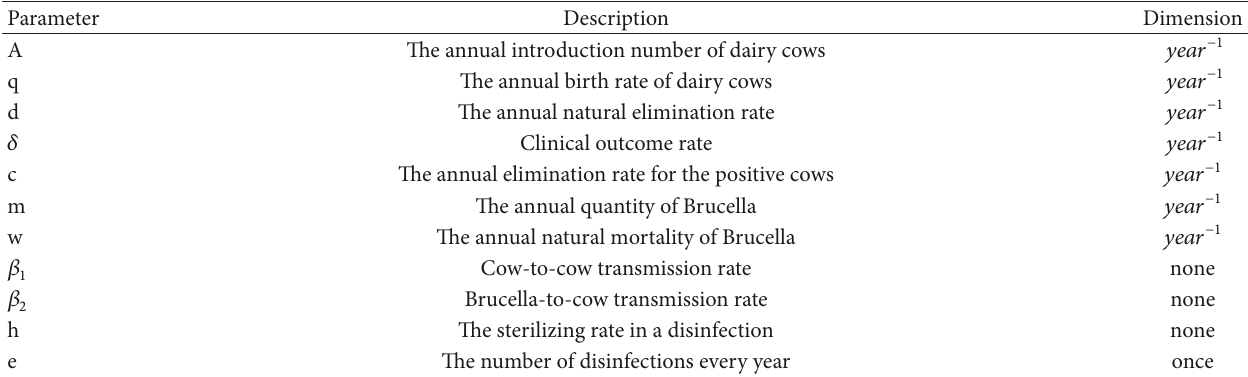
Table 1: The description of parameters in original